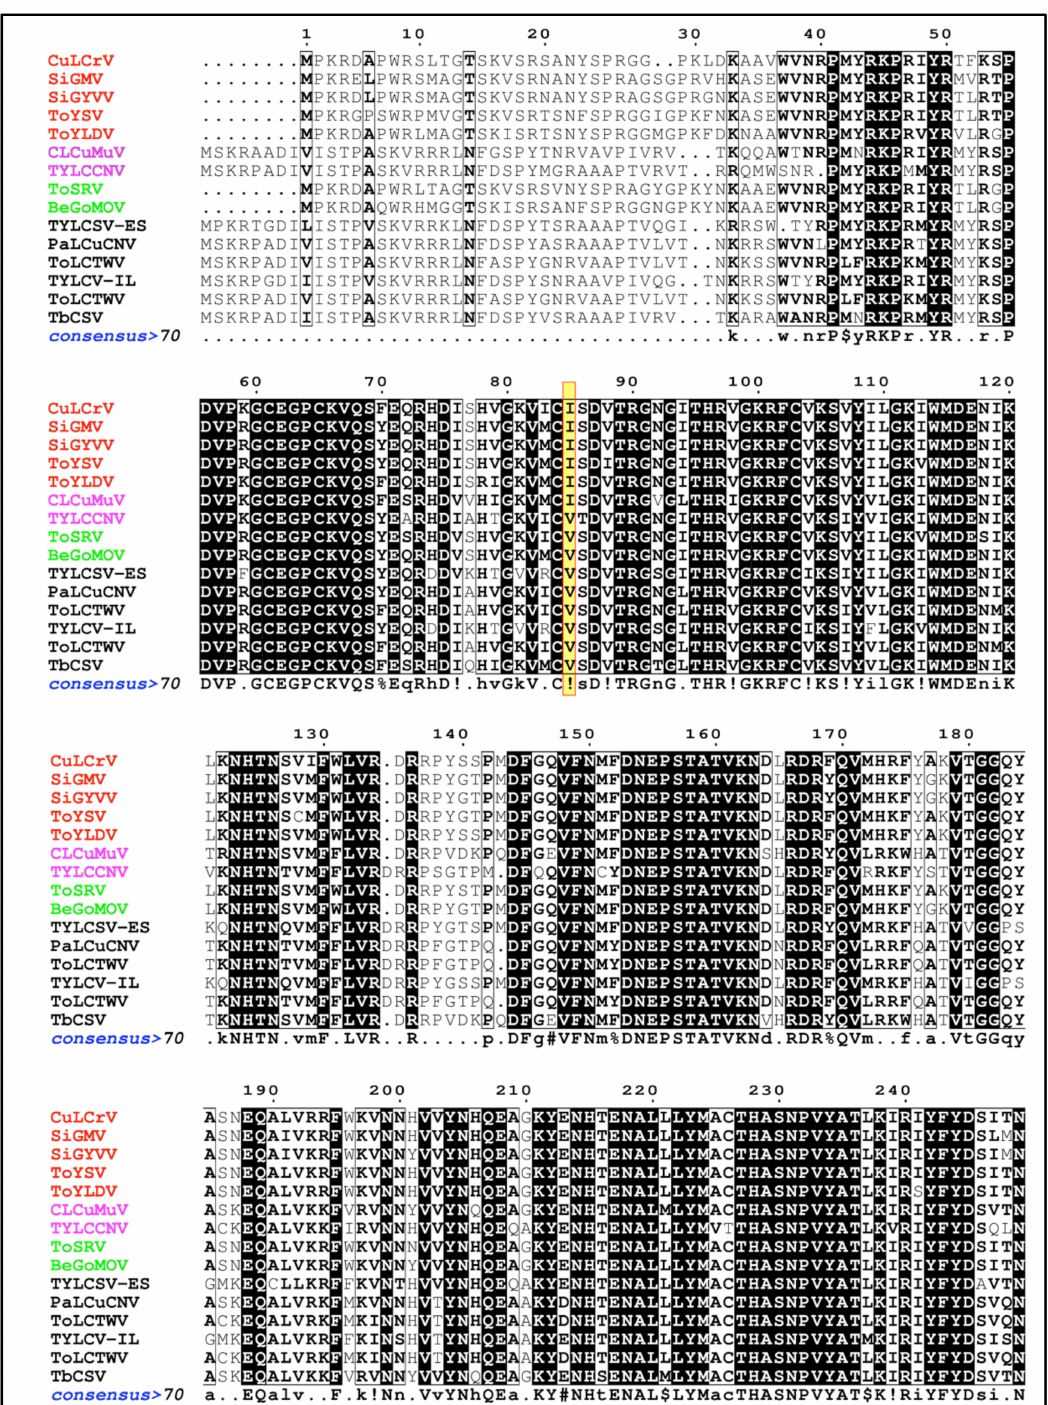
Figure 6. Comparison of capsid protein amino acid sequences of B. tabaci MED transmissible and non-transmissible begomoviruses. New-World non-transmissible (red); Old-World non-transmissible (magenta); New-World transmissible (green); and Old-World transmissible (black) begomoviruses. A consensus sequence was generated using MultAlin criteria: uppercase is identity lowercase is consensus level > 0.5, ! is I or V, $ is L or M, % is F or Y, and # is N, D, Q, E, B or Z. At amino acid residue 85 (highlighted in yellow), all B. tabaci MED-non-transmissible viruses except for tomato yellow leaf curl China virus (TYLCCV) had valine, whereas B. tabaci MED-transmissible viruses had